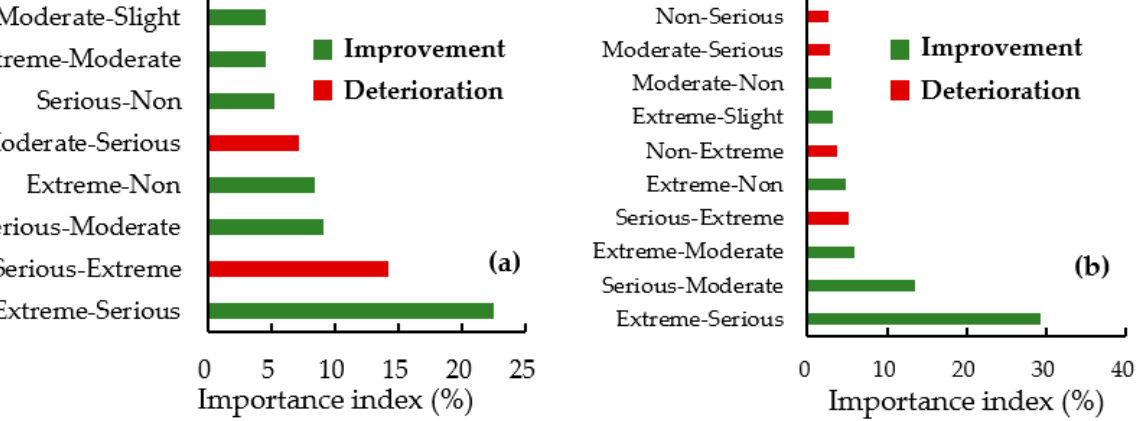
Figure 7. The importance index of different salinized soil types during 2000 to 2010 ( a ) and 2010 to 2017 ( b ).